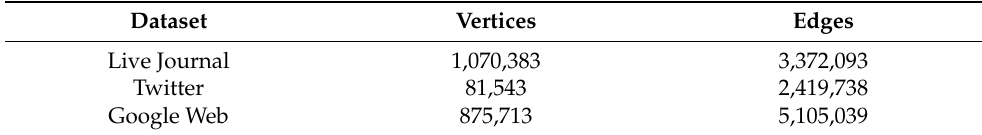
Table 1. Characteristics of the experimental